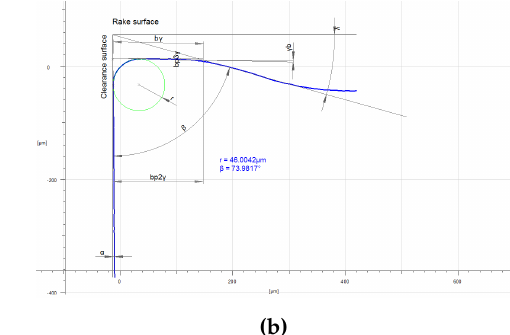
Figure 4. Experimental tool; ( a ) insert, ( b ) cutting edge